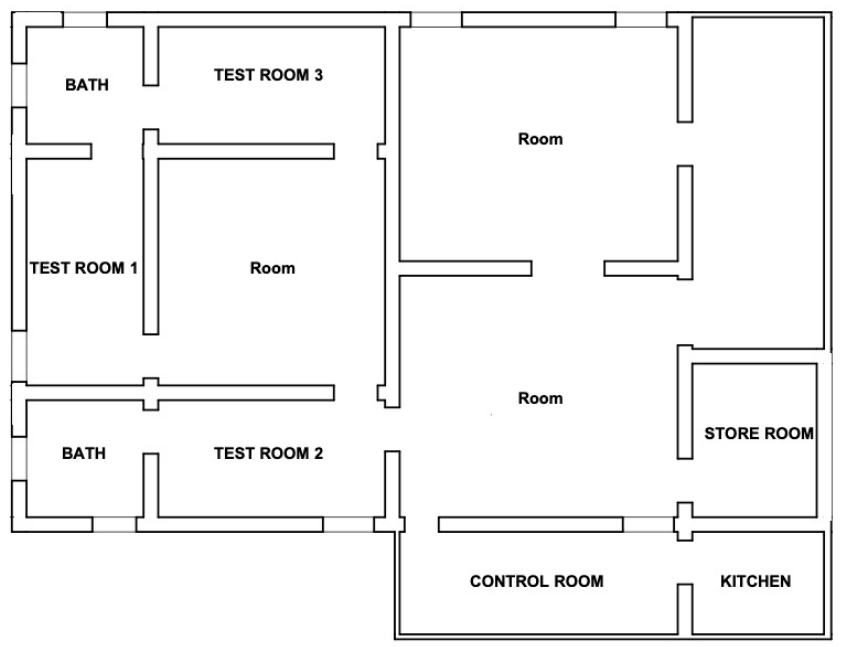
Figure 2. Floor plan of the case study building.